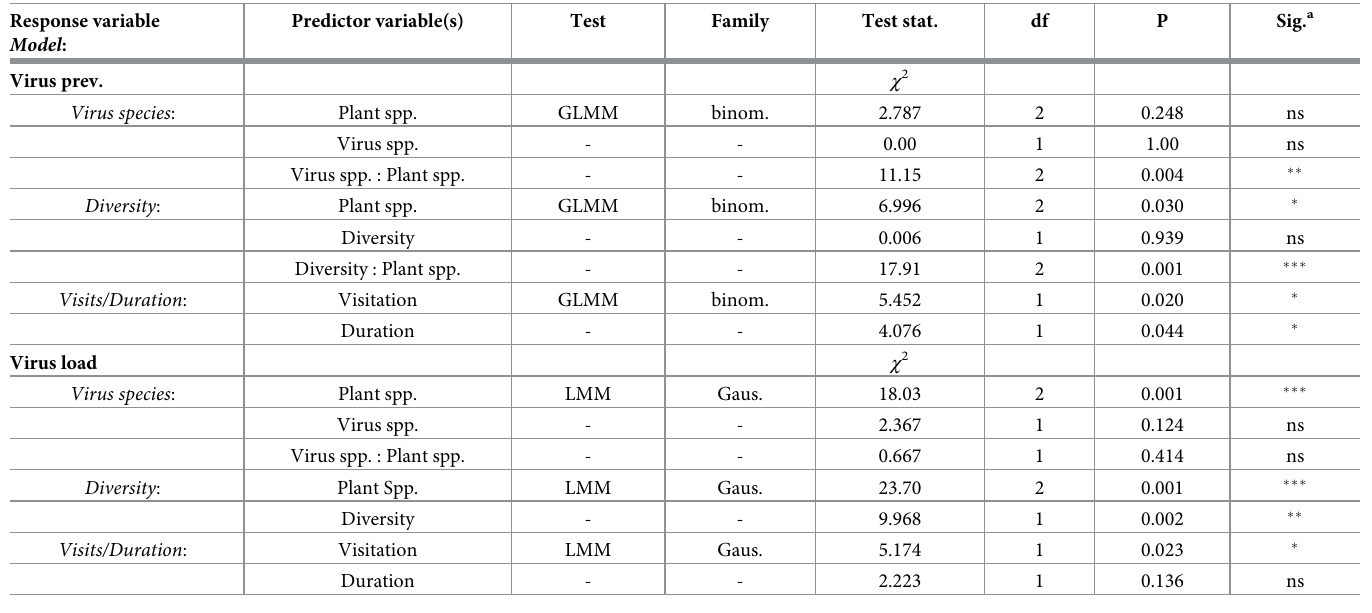
Table 2. Summary statistics for all statistical models. For each model, the response variable and predictor variables are outlined with relevant summary of statistics. Virus prev. is virus prevalence and is reported as the number of plants samples with virus detected divided by the total number of plant samples in the dataset multiplied by 100. Virus load is presented as virus genome copies per flower sample. Plant spp. refers to the plant species used in the experiments: Lotus corniculatus (Birdsfoot trefoil), Trifolium pratense (red clover), or Trifolium repens (white clover). Virus species are either deformed wing virus (DWV) or black queen cell virus (BQCV). Diversity is either ‘single species.’, ‘mix of three species’. In the “single species” experiment, bees foraged on arrays consisting of only one species at a time. In the “mix of species” exper- iment, bees foraged on arrays consisting of all three plant species at once. Visitation (visitation rate) was calculated as the number of honey bee visits to flowers/hour. Dura- tion (visit duration) was calculated as the amount of time each honey bee forager visited to an inflorescence (in seconds).